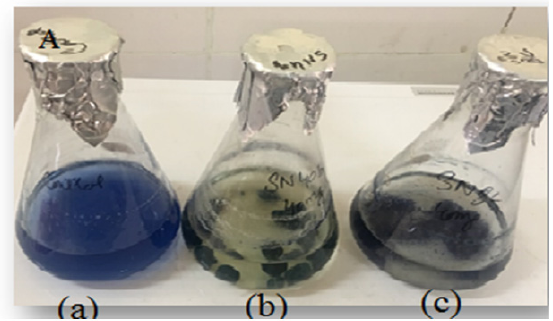
Figure 1. The decolorization of RBB dye in liquid medium: ( a ) control, ( b ) SN40b, and ( c ) SN8c .